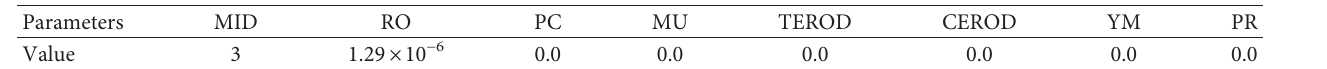
Table 9: Parameters of ∗ MAT_NULL